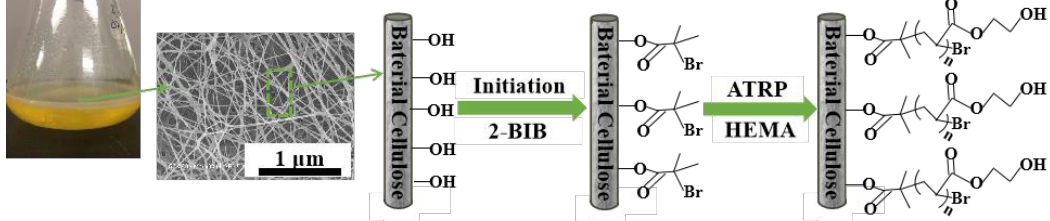
Figure 1. Schematic showing the grafting of poly 2-hydroxyethyl methacrylate (poly(HEMA)) on the surface of bacterial cellulose (BC) membrane via the atom transfer radical polymerization (ATRP)